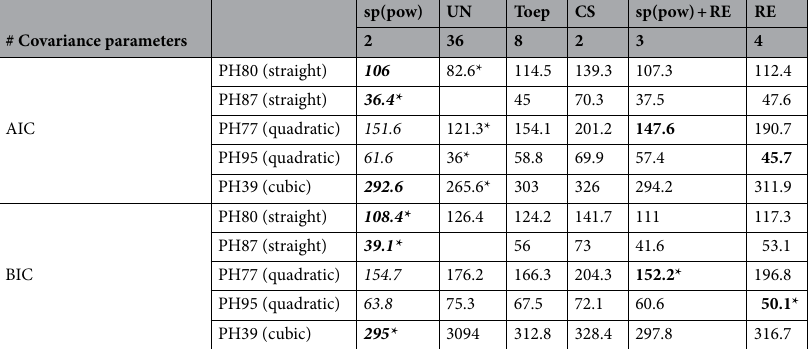
Table 2. REML information criteria for choosing variance/covariance structure, comparable since the mean model is fixed for each PDX model across the variance/covariance structures. Lower values are better for both AIC and BIC, and the lowest is indicated by *. As with the mean models, AIC favors more complex models, while BIC includes a penalty for the number of parameters estimated so tends to favor more simple models with fewer parameters. Bold font indicates our choice if that was the only PDX model being considered; italic font indicates the common choice for simplified reporting. REML Restricted (or residual) maximum likelihood, PDX Patient derived xenograft, AIC Akaike information criterion, BIC Bayesian information criterion, Sp(pow) Spatial(power), UN Using unstructured, Toep Toeplitz, CS Compound symmetric, RE Random